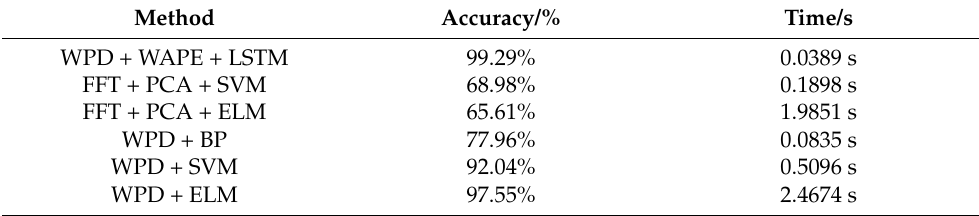
Table 7. Comparison of different